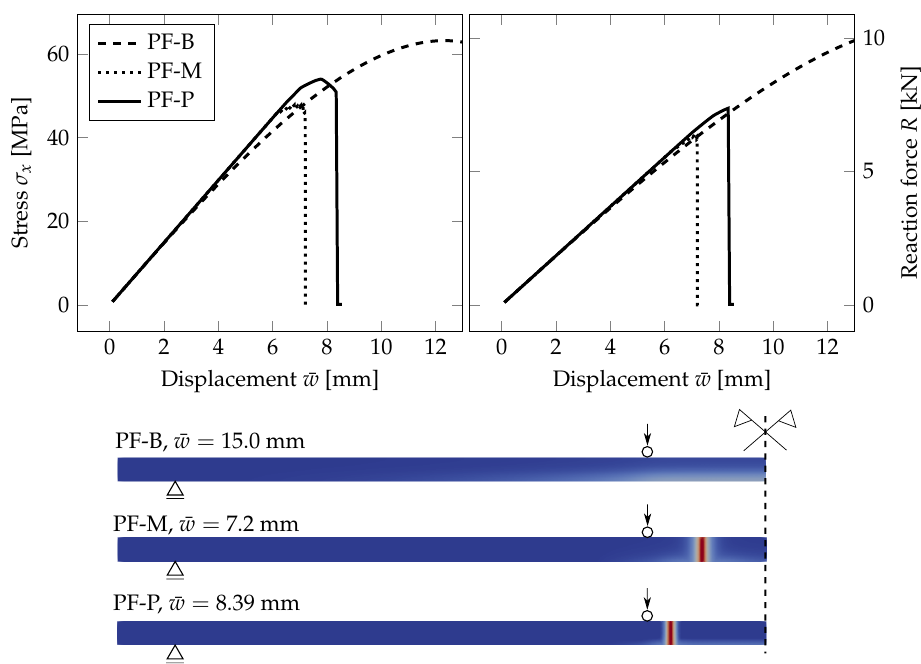
Figure 5. PS-Uniform mesh, anisotropic staggered solver with the spectral-decomposition split: Comparison of phase-field formulations in terms of the evolution of the largest tensile stress at the midpoint and the overall reaction under the loading points for the prescribed displacement, complemented with the damage evolution plot showing the position of the localised cracks (red).